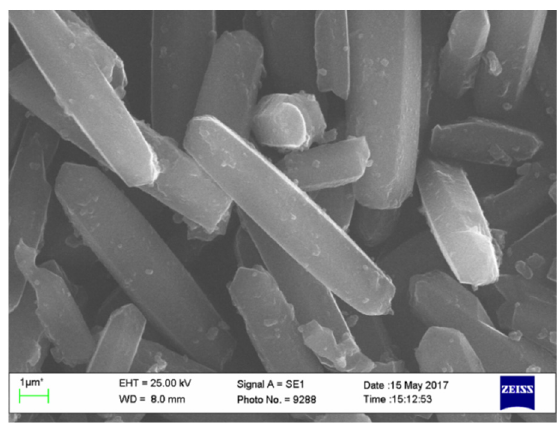
Figure 3. SEM image of crystallized CPO-27-Mg.